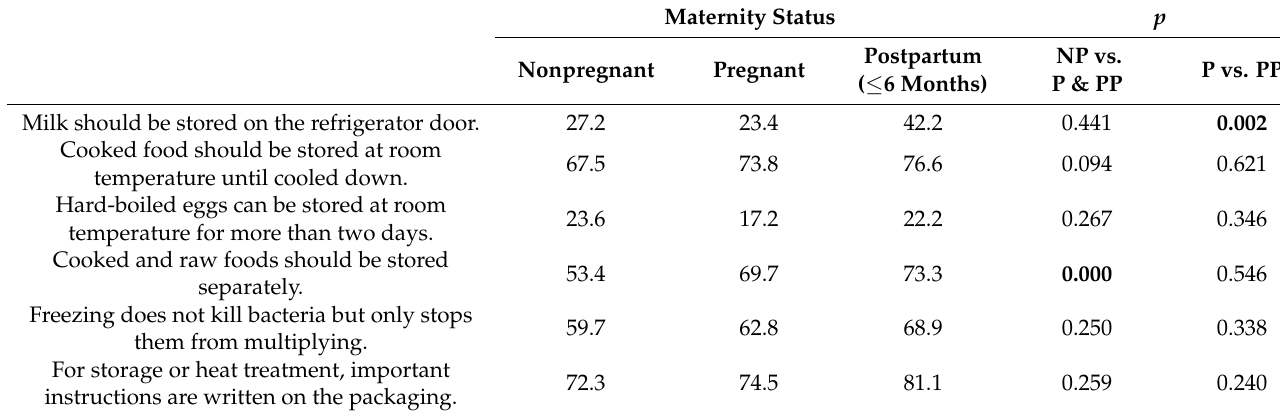
Table 5. Compliance rate (%) regarding food storage practices by maternity